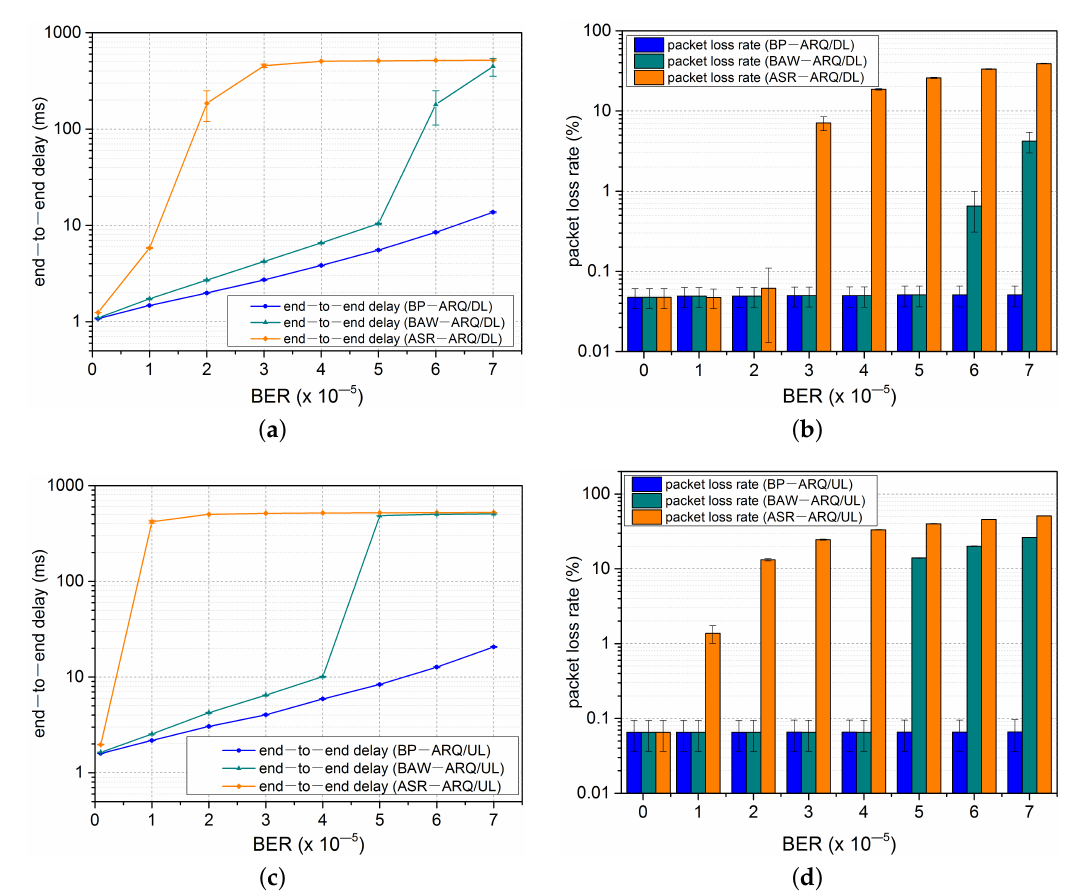
Figure 13. The end-to-end delay and packet loss rate vs. the BER . ( a ) The end-to-end delay in the downlink. ( b ) The packet loss rate in the downlink. ( c ) The end-to-end delay in the uplink. ( d ) The packet loss rate in the